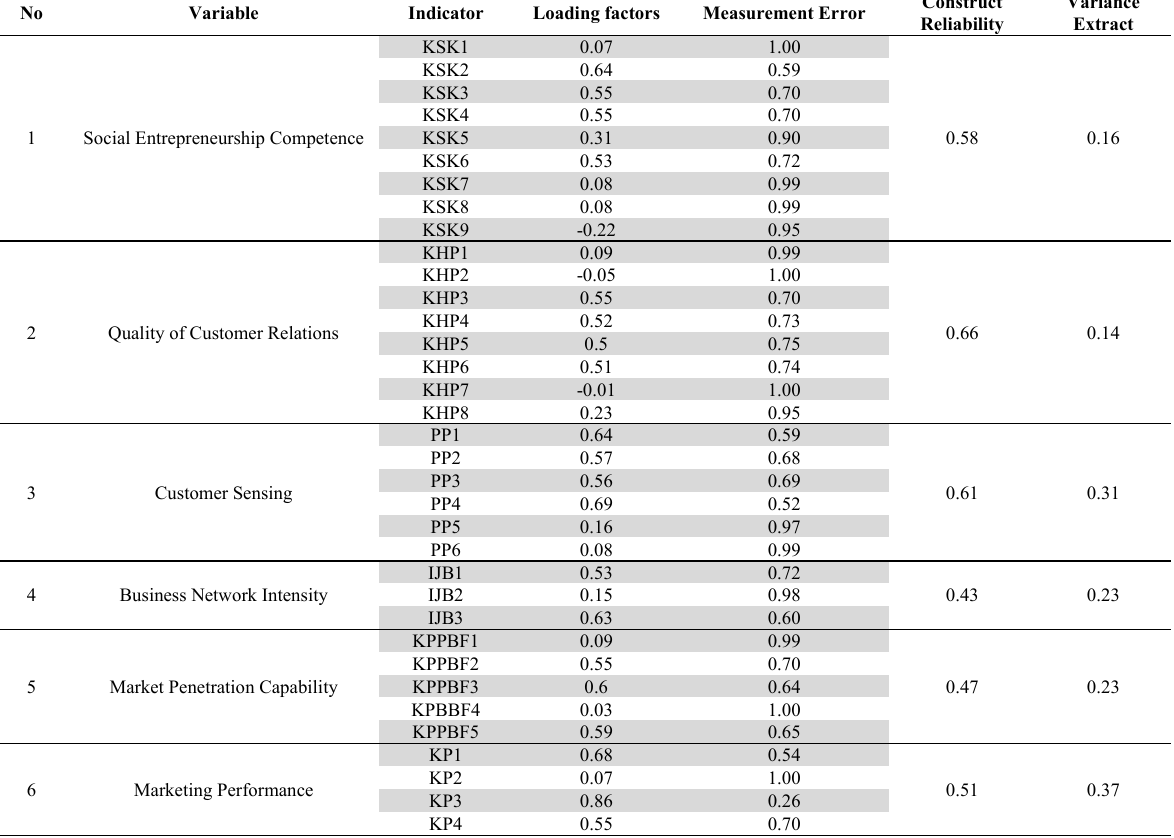
Testing reliability and variance extract